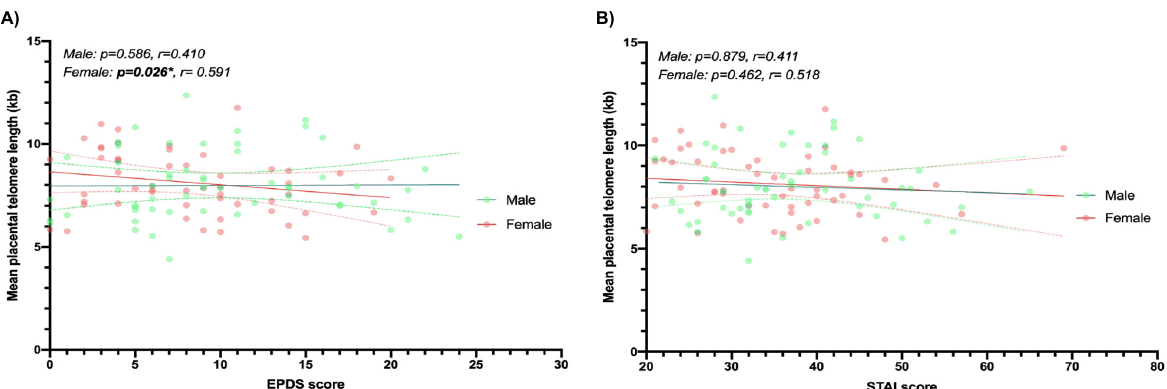
Figure 3. Telomere length differences in placenta according to mood scores (EPDS and STAI) for males ( n = 55) and females ( n = 54). The association between maternally reported depression symptoms (EPDS score) and mean placental telomere length ( A ), and the association between maternally reported anxiety symptoms (STAI score) and mean placental telomere length ( B ) are shown as linear